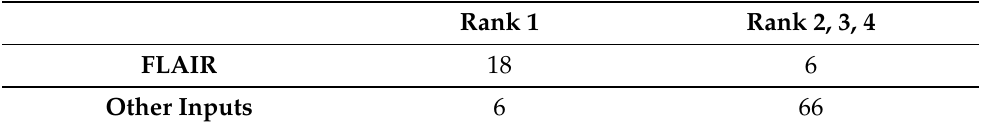
Table 4. Shown is a contingency table that categorizes a total of 96 distinct model performances. This table shows how often FLAIR achieved the best performance (Rank 1) relative to the other performances (Rank 2, 3, and 4) for the other inputs. A Fisher’s exact test determined that the distribution of model performances was statistically significant ( p < 0.00001).